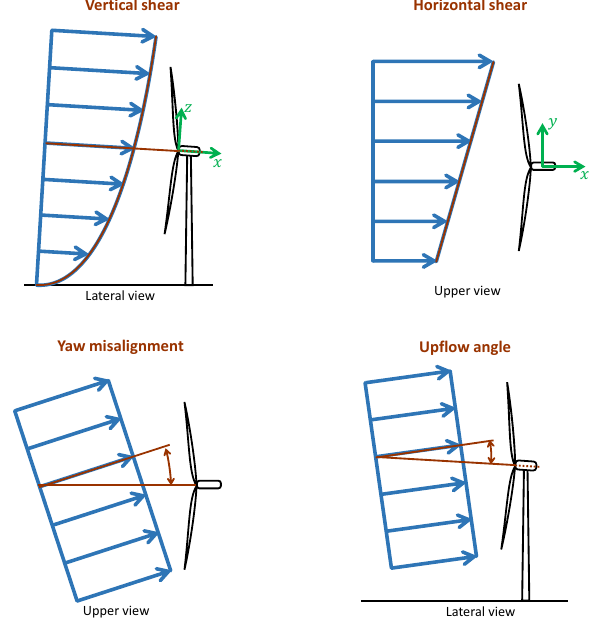
Figure 1. Definition of the four wind states used for parameterizing the wind field over the rotor